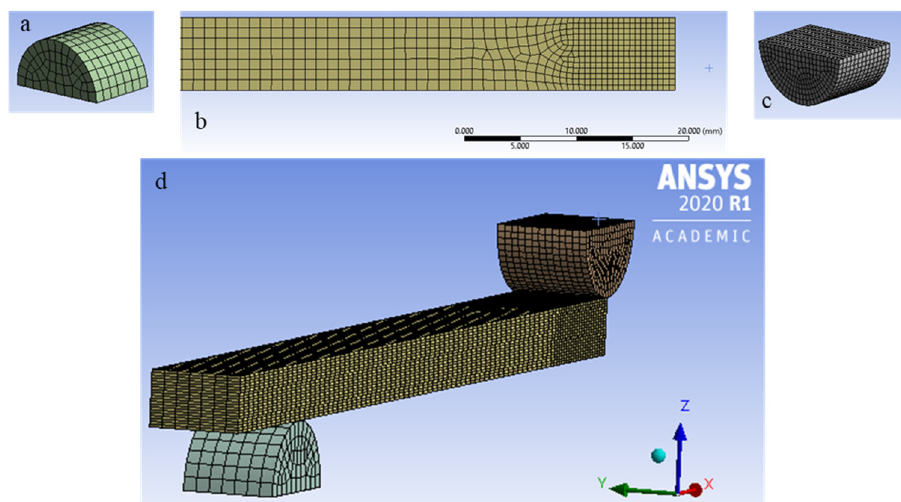
Figure 3. FEA mesh of ( a ) support roller, ( b ) sample, and ( c ) loading roller; ( d ) complete mesh with sample and rollers.